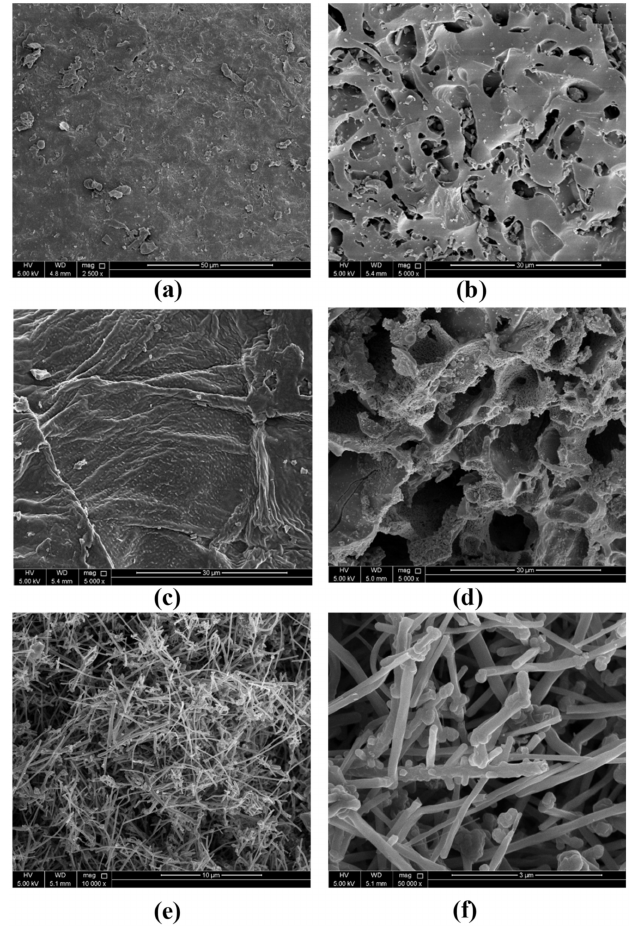
Figure 9. SEM micrographs of ( a ) RPNS, ( b ) TTPNS500, ( c ) ADAV, ( d ) TTAV500, ( e ) MWCNTs 10 µ m magnification and ( f ) MWCNTs 3 µ m